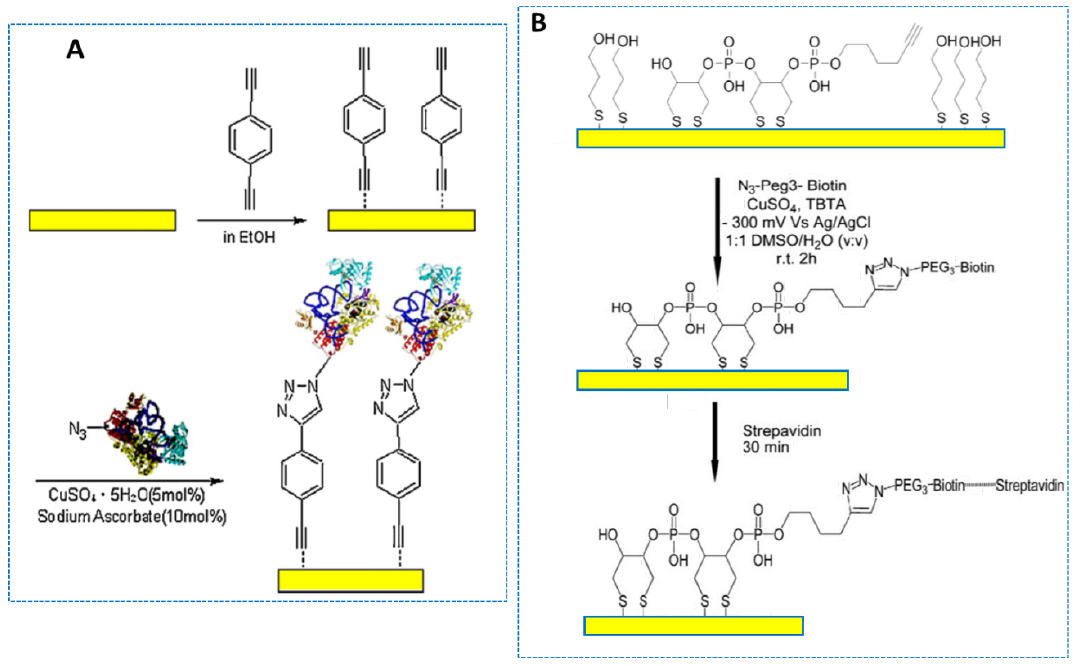
Figure 6. Preparation of a HRP-DEB biosensor ( A ). Functionalization of gold surface with bis(DTPA)-hexynyl and mercaptopropanol; biotin grafting by click reaction followed by streptavidin binding ( B ). Reproduced from [53] ( A ) and [59] ( B ) with